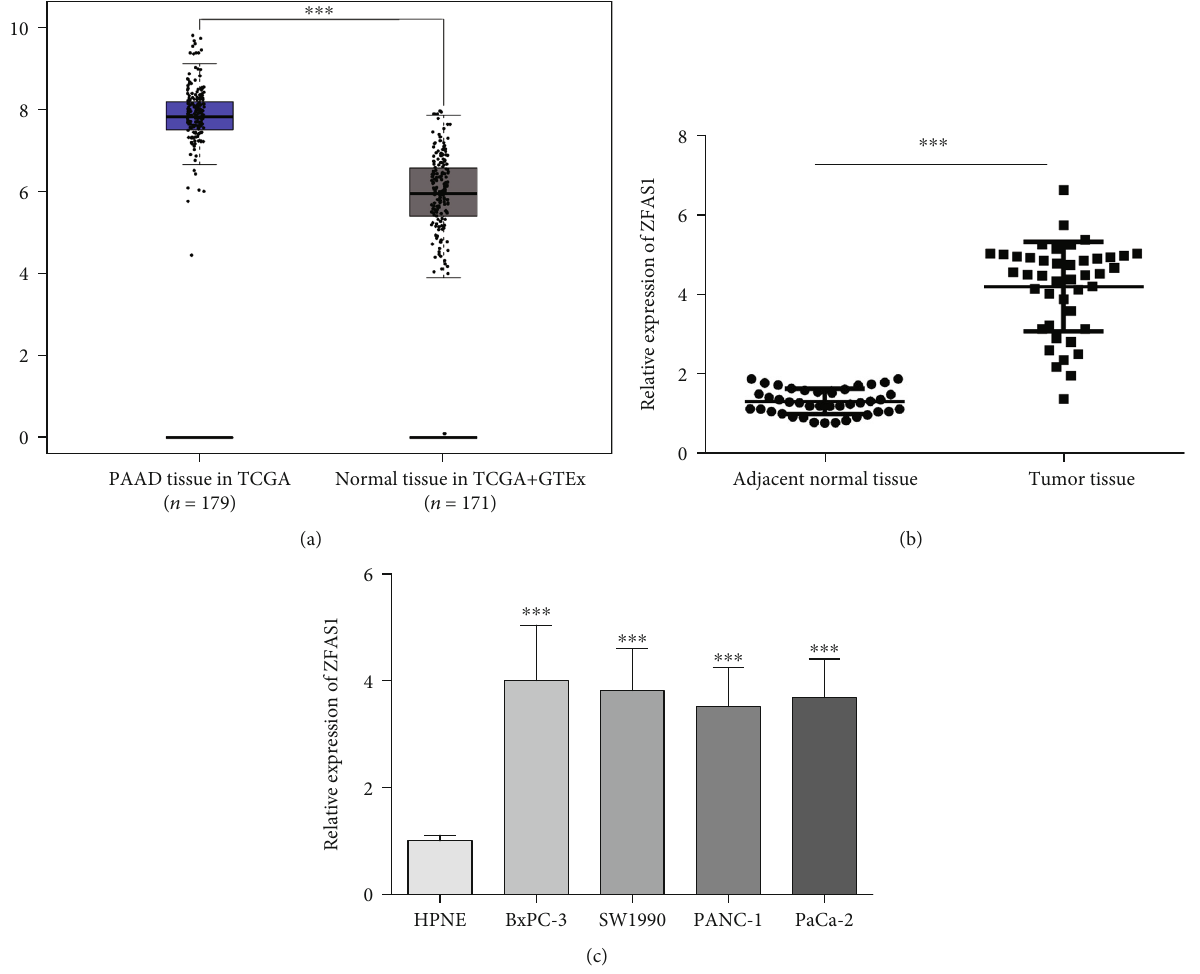
Figure 1: ZFAS1 in PC. (a) ZFAS1 expression in TCGA+GTEx database samples; (b) ZFAS1 expression in clinical samples; (c) ZFAS1 in di ff erent cell strains; ∗∗∗ P < 0 : 001 vs. HPNE